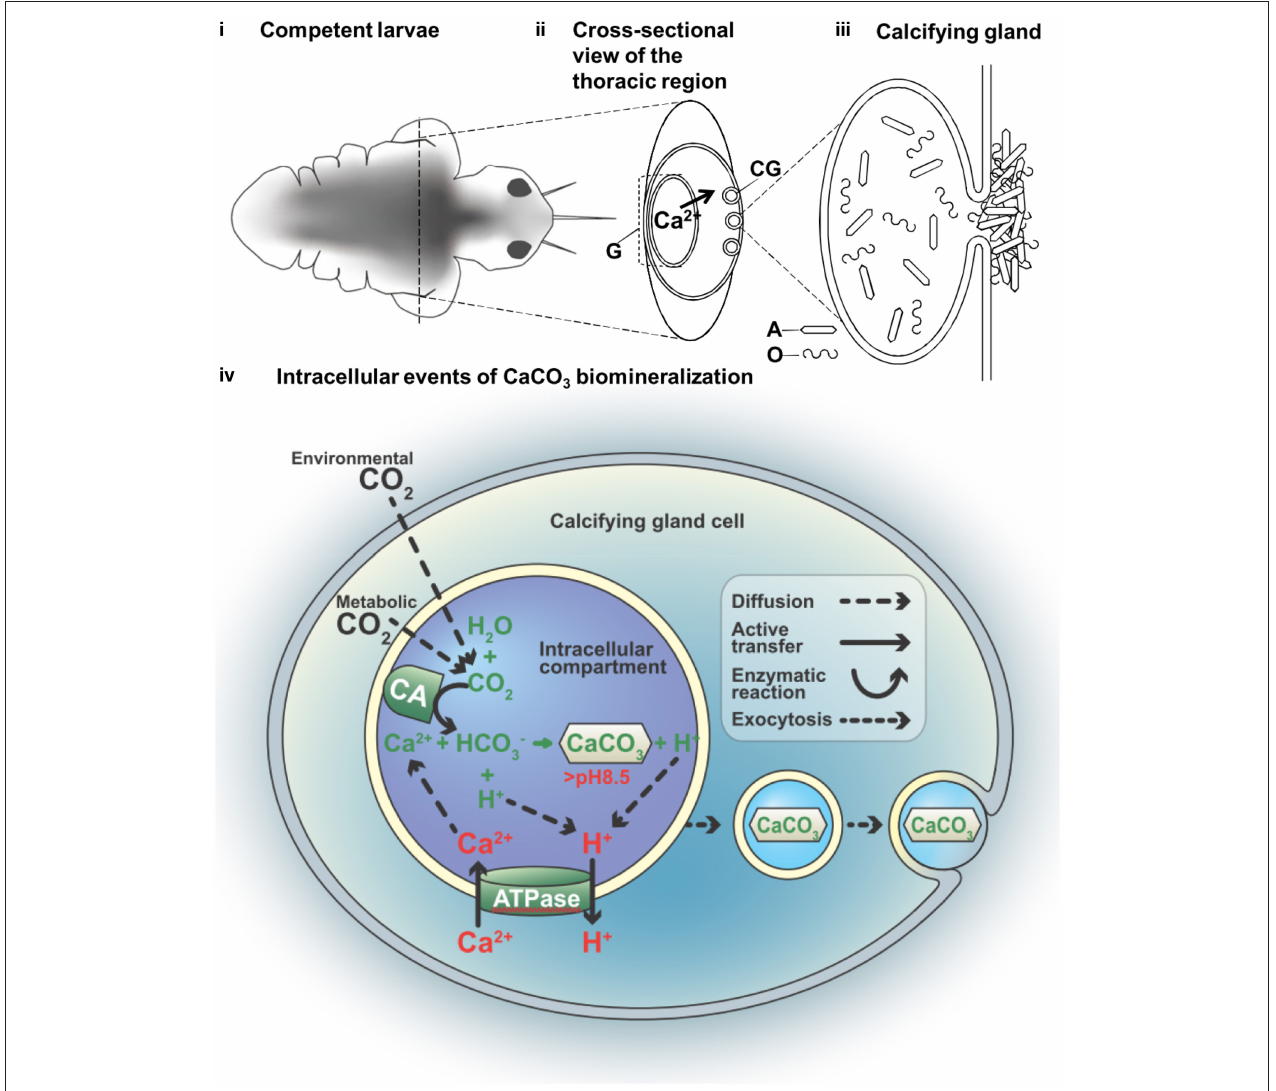
FIGURE 4 | A hypothetical model of the compartmental crystal formation in the body of the tubeworm Hydroides elegens . (i) Empirical data indicates calcifcation activities in the thoracic region of the competent larvae at day 7 (eyespots are visible). (ii) A cross-sectional view of thoracic region through the axis delineated in (i) depicts the flux of Ca 2 + ions. The serpulid tubeworms commonly produce calcium carbonate through dietary calcium ions from the gut, requiring an active transporting, or pumping of Ca 2 + from the gut (G) to the calcifying glands (CG). (iii) A calcifying gland depositing aragonite crystals (A) together with the organic (O) component of the biomineral are deposited to the surface of the body; shown via a schematic representation of the possible intracellular events in the process of the CaCO 3 biomineralization (iv) nucleation of CaCO 3 from bicarbonate ion (HCO − 3 ) and (Ca 2 + ) involves the function of carbonic anhydrase (CA) and an ATP driven Ca 2 + /H + antiport (ATPase). This process is thought to occur in an intracellular compartment to prevent the toxicity associated with high Ca 2 + in the cytosol. The deposition of CaCO 3 to the surface of the body causes a migration of the mineral along the cytosol, via an event similar to